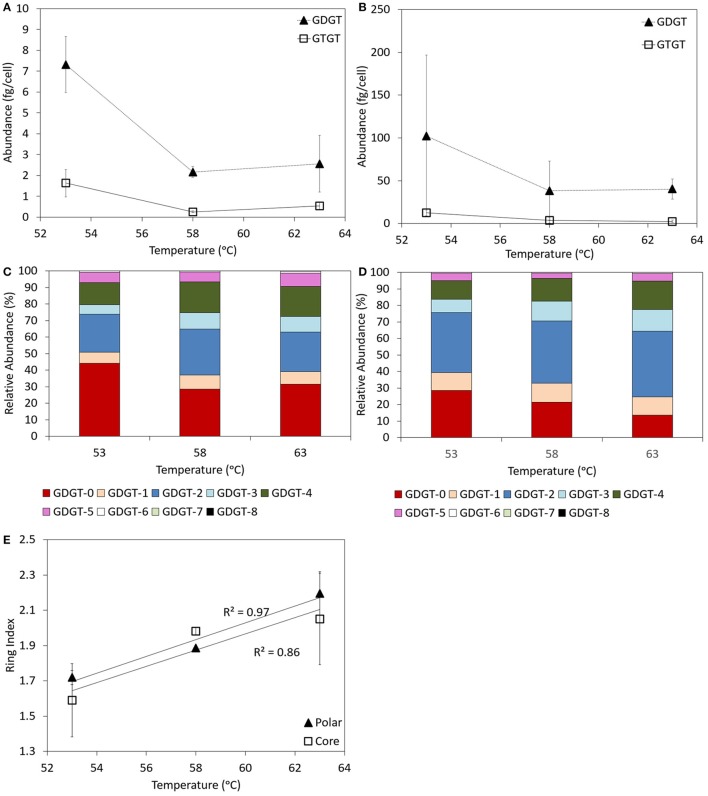
Abundance of GDGT and GTGTs per cell in the core (A) and polar (B) fractions of batch cultures of P. torridus grown at different incubation temperatures. Relative abundance of individual GDGT lipids in the core (C) and polar (D) lipid fractions of log phase cells of P. torridus incubated at different temperatures. Calculated ring indices for log phase cultures of P. torridus grown at varying incubation temperatures (E). All cultures were grown in media with a pH of 0.7. Error bars in panels (A,B,E) represent the standard deviation of three replicate cultures.